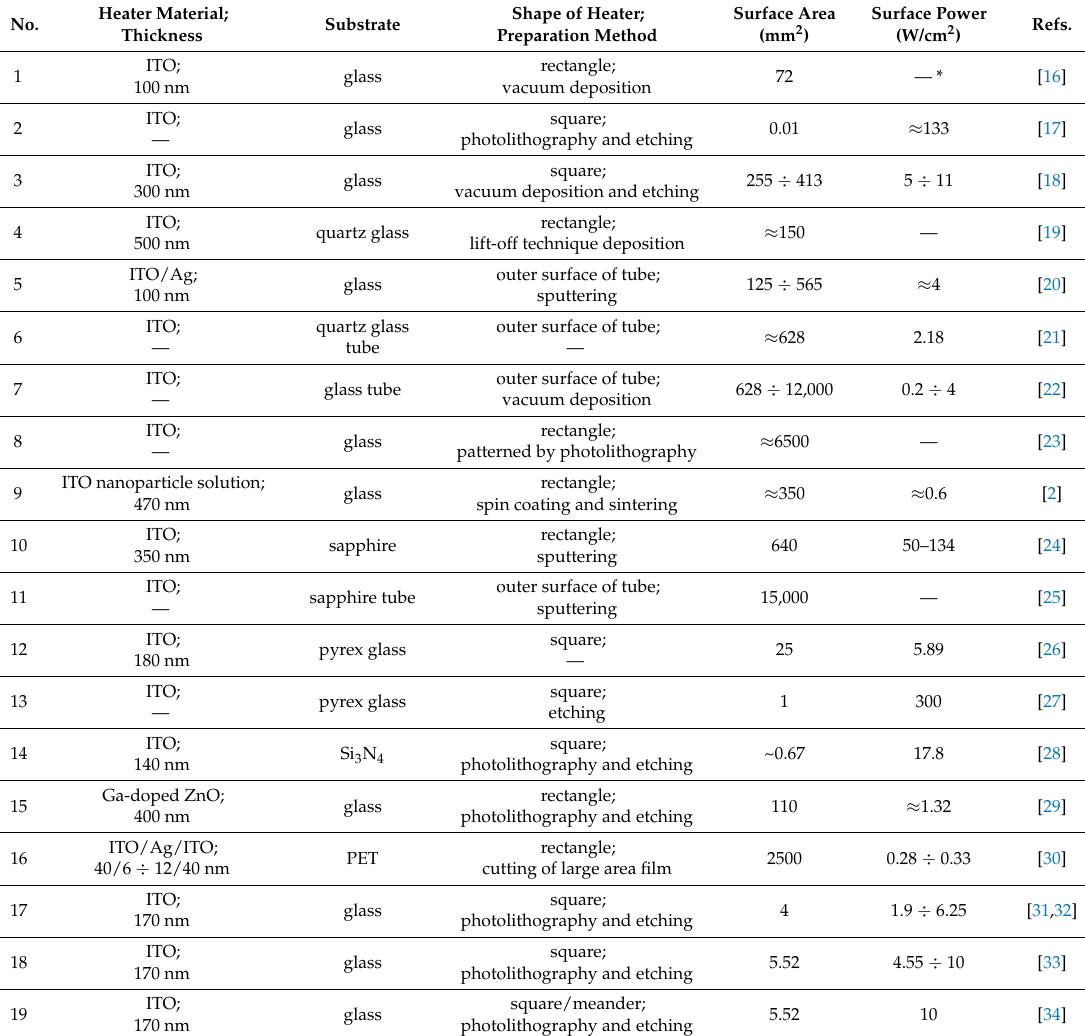
Table 1. Heaters based on transparent